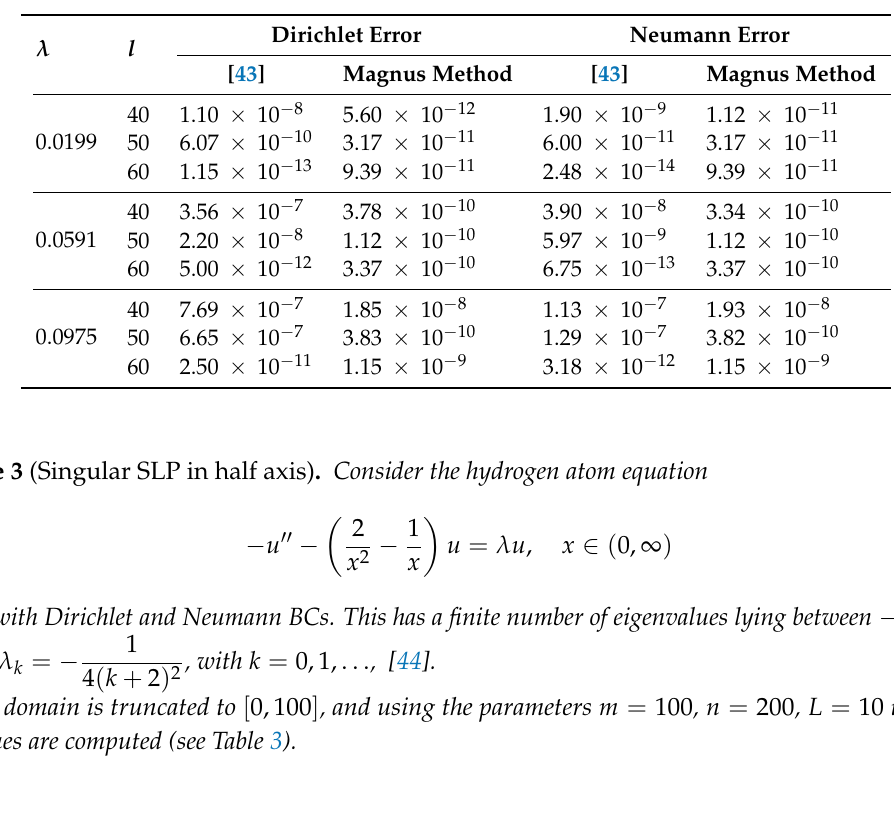
Table 2. Absolute errors for the first three eigenvalues of Equation (28) from Table 2 of Ta¸seli [43] and using Magnus